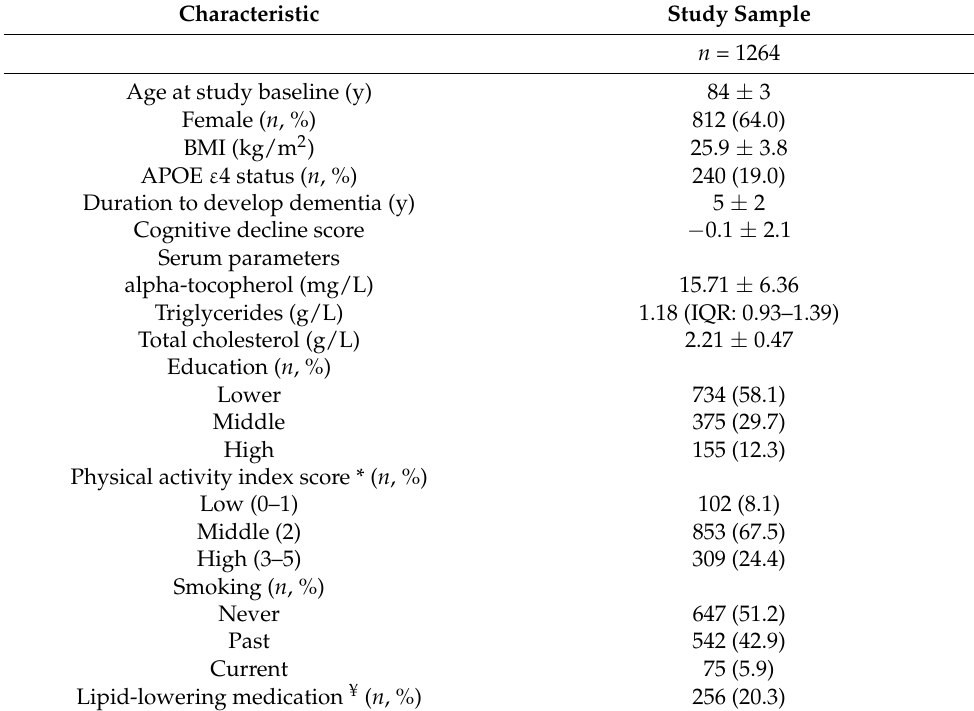
Table 1. Participants baseline